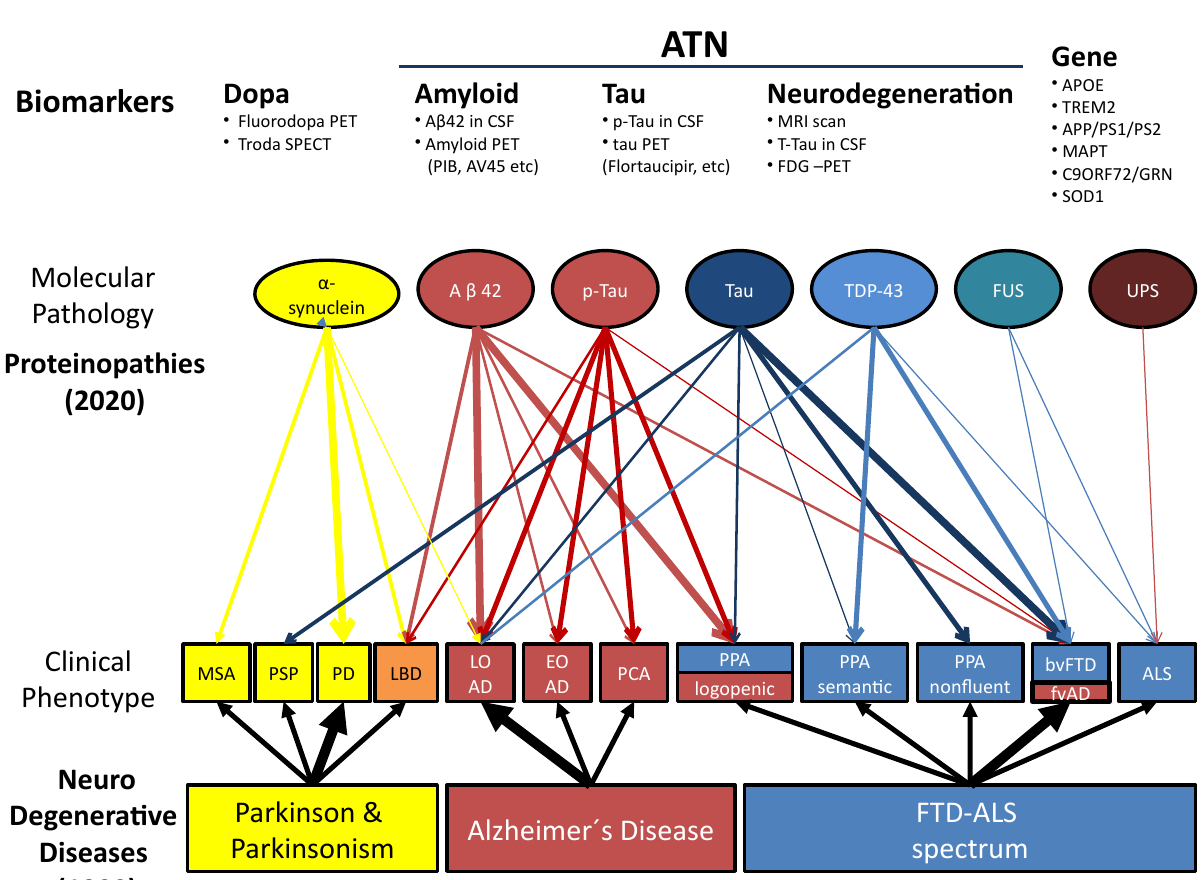
Figure 1. Proteinopathies in neurodegenerative